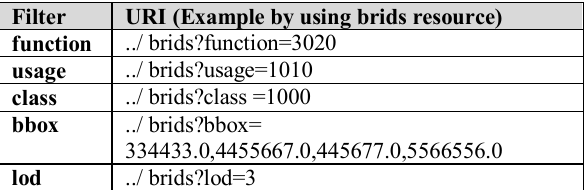
Table 1. General filters